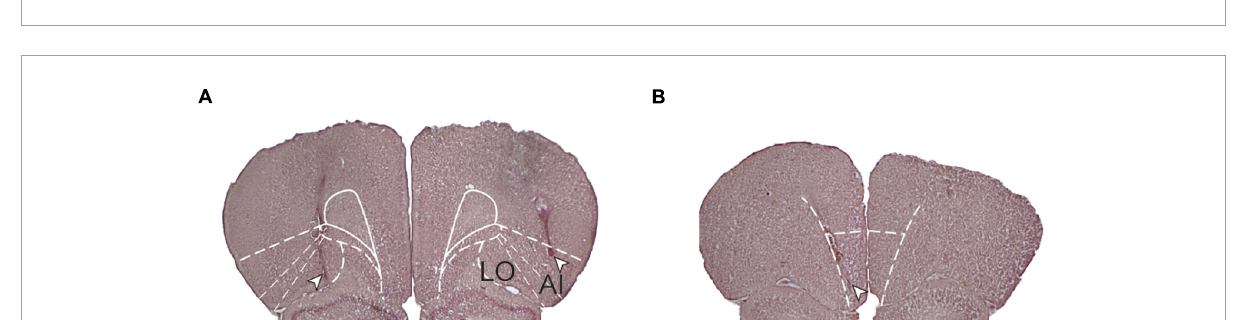
FIGURE1 Experimental design of the study.